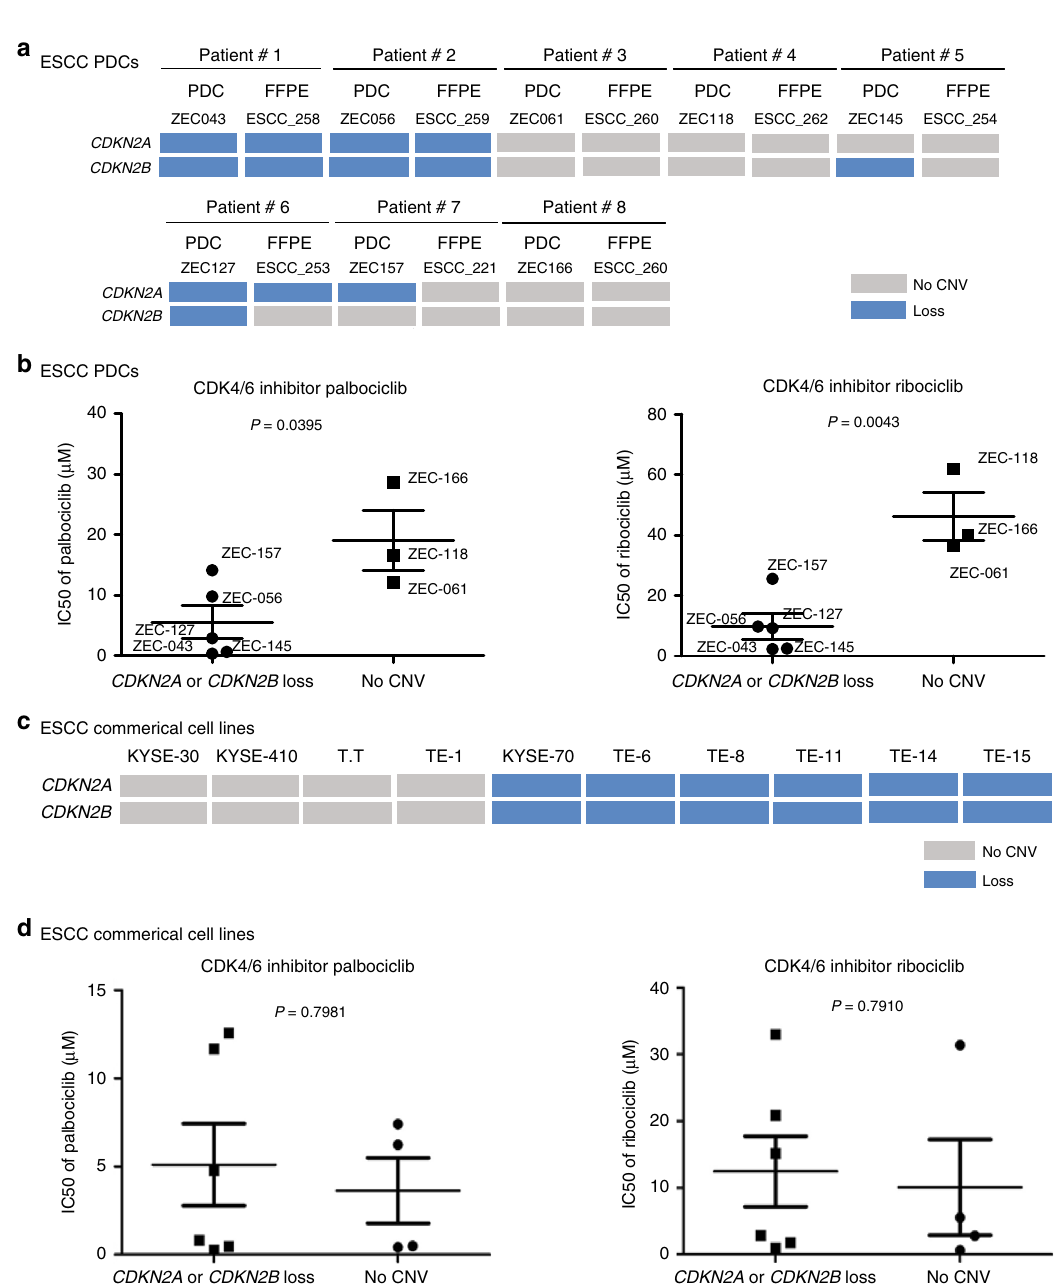
Fig. 3 Validation of the biomarkers in PDCs and commercial cell lines. a The copy number variations (CNVs) of CDKN2A and CDKN2B were shown in eight ESCC PDCs and their corresponding tumor tissue. b Fifty percent growth inhibitory concentrations (IC50s) of palbociclib and ribociclib (LEE011) in eight ESCC PDCs with CDKN2A or CDKN2B loss or with no CNV of CDKN2A and CDKN2B . c The CNVs of CDKN2A and CDKN2B were illustrated in ten commercial cell lines. d IC50s of palbociclib and ribociclib in ten ESCC commercial cell lines with CDKN2A or CDKN2B loss or with no CNV of CDKN2A and CDKN2B . Error bars correspond to the standard deviation of IC50s. The comparisons between different groups of compound IC50s were performed using Student ’ s t